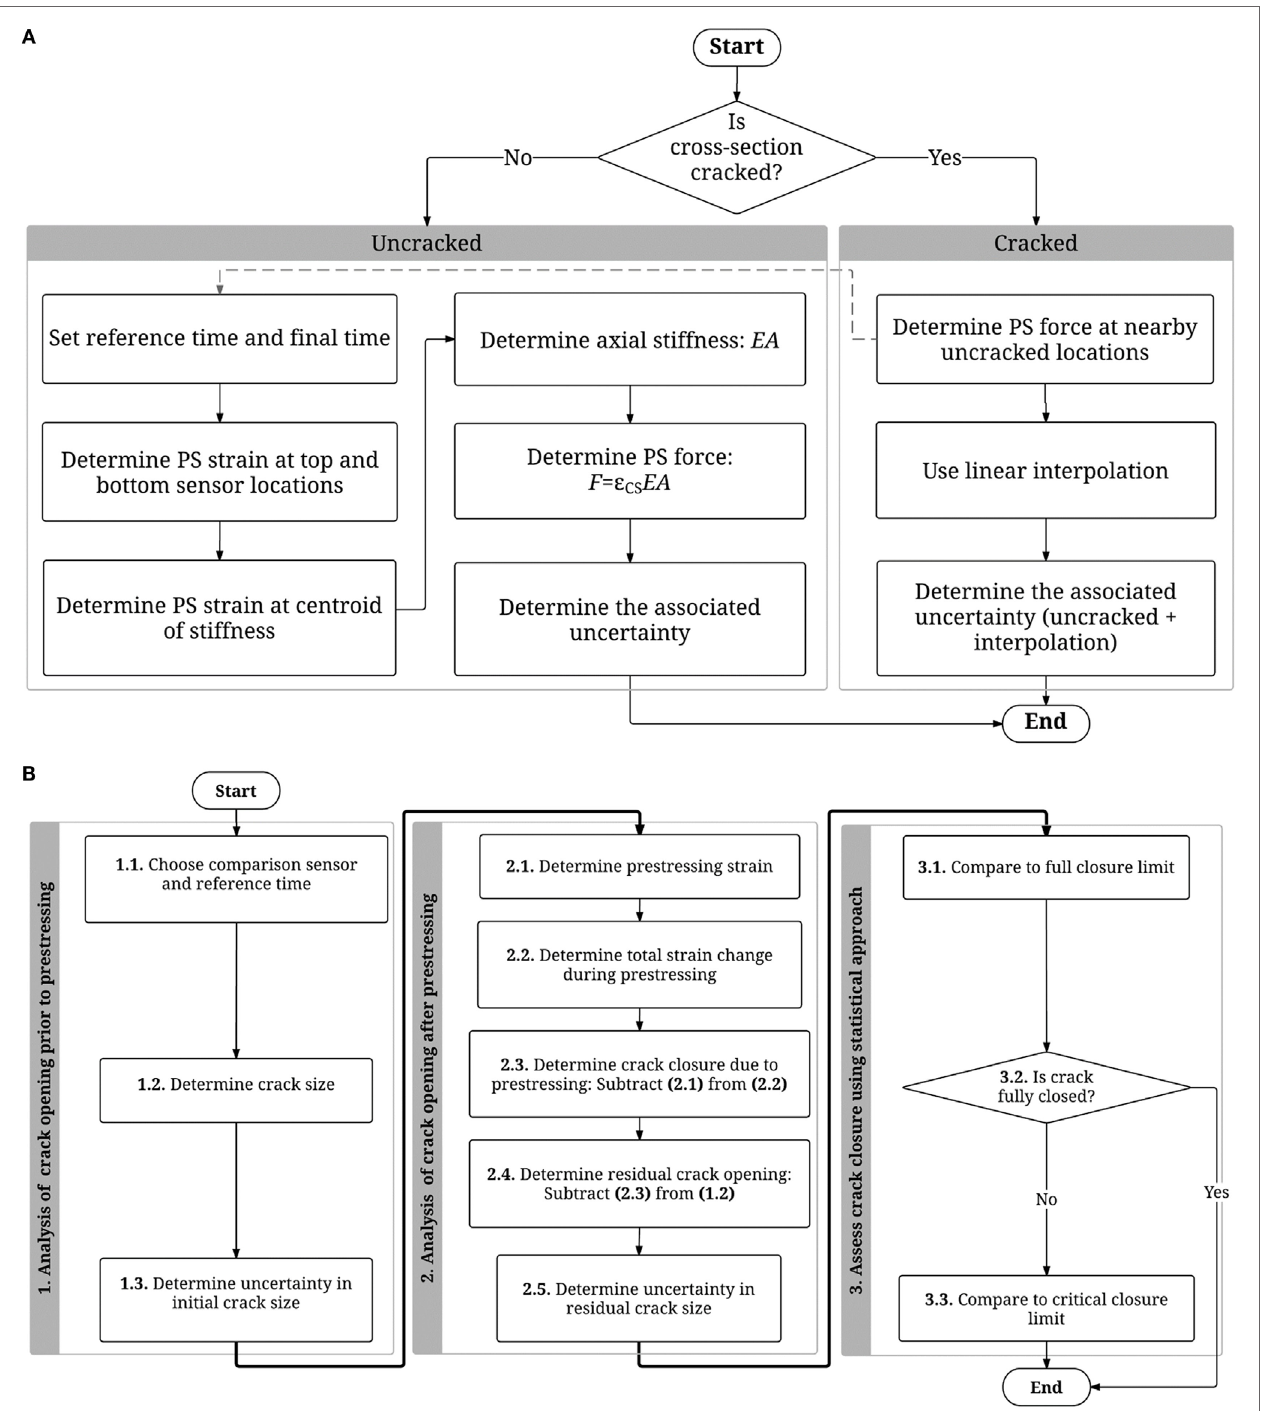
FIGURe 5 | Flowcharts detailing the methods of analysis for the evaluation of (A) prestressing forces and (B) prerelease crack width